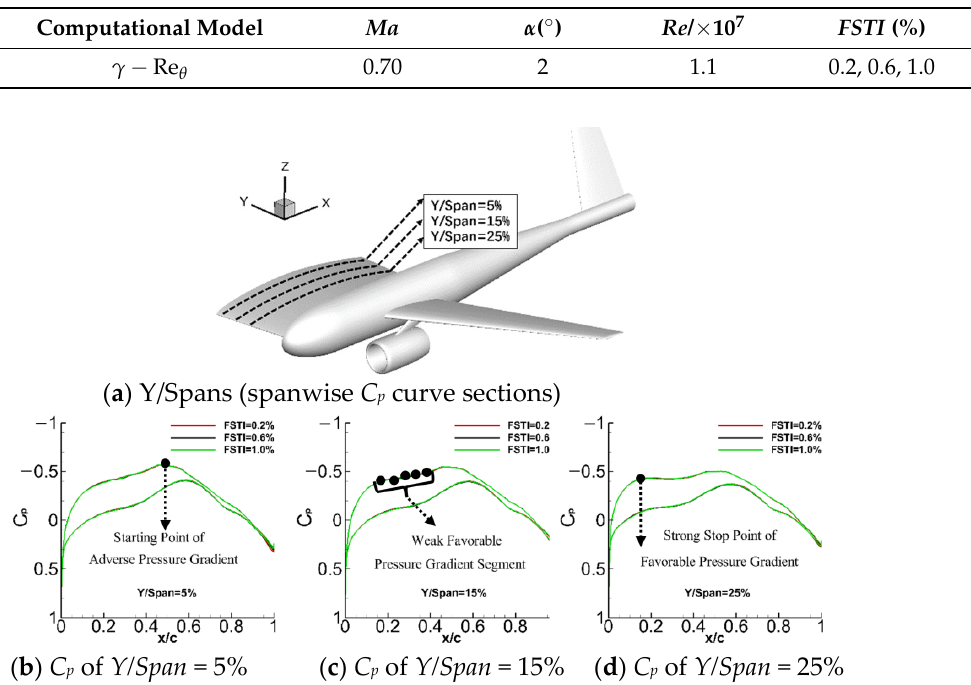
Table 3. Calculated states and method for different FSTI .